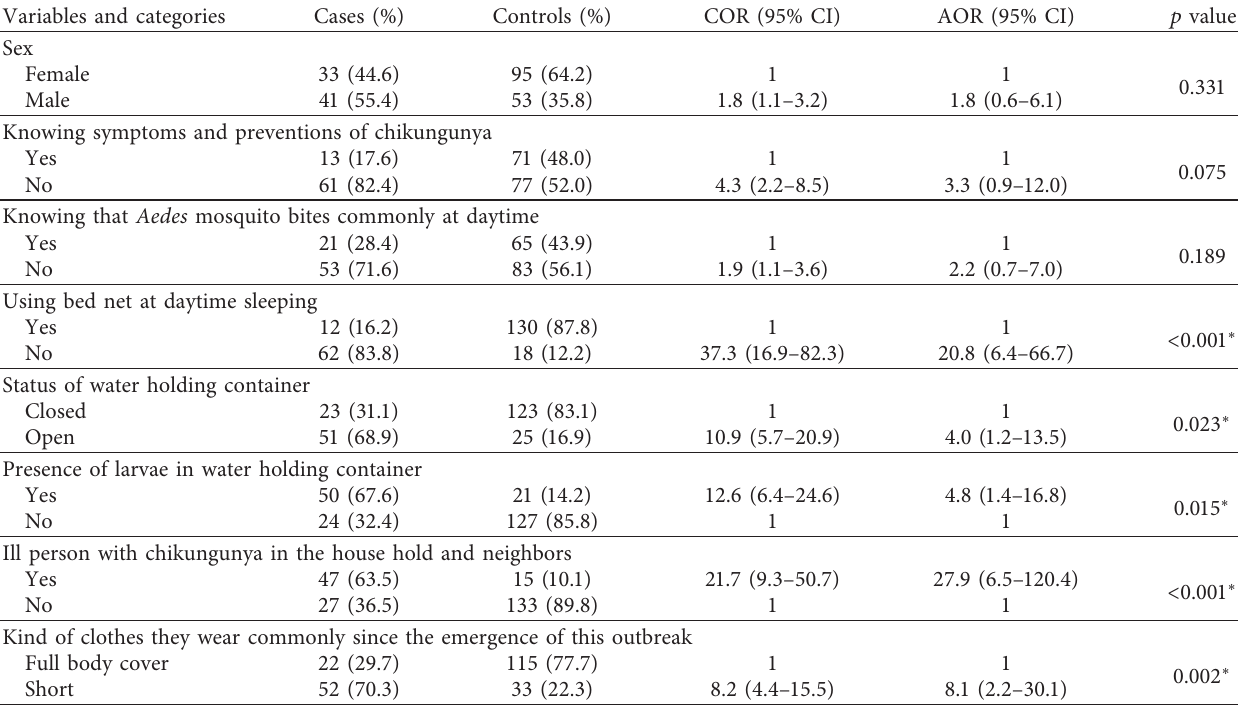
Table 5: Multivariable analysis of chikungunya risk factors in Kebridahar City Administration of Somali, Ethiopia, 2019. Variables and